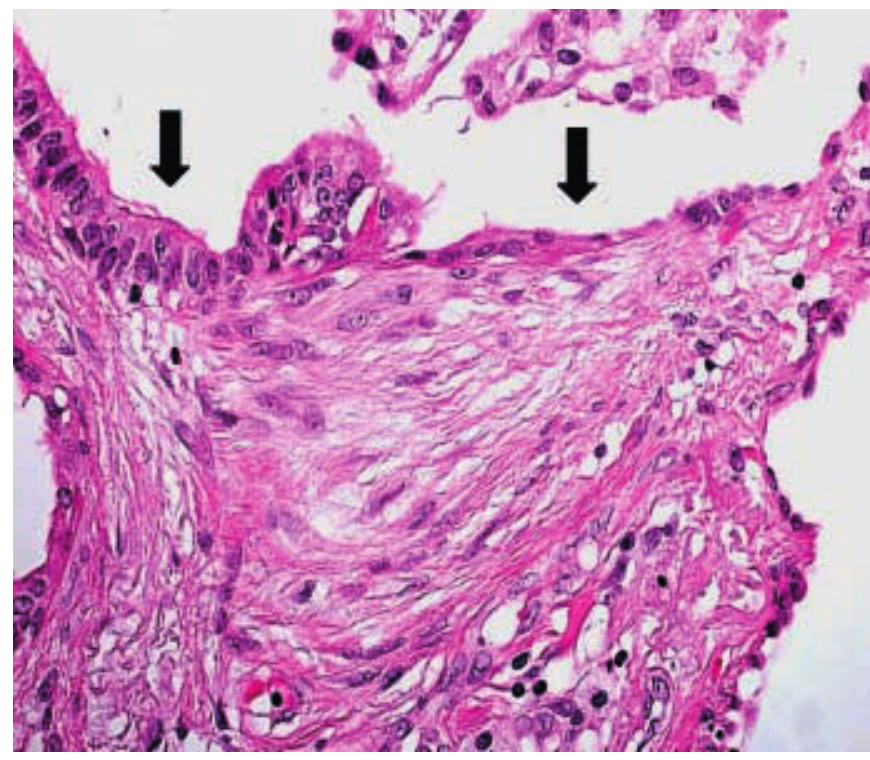
Figure 1 Fibroblast foci in an IPF/UIP lung. Notice the hyperplastic alve- olar epithelial cells migrating over the extracellular matrix (arrows) (haema- toxylin and eosin